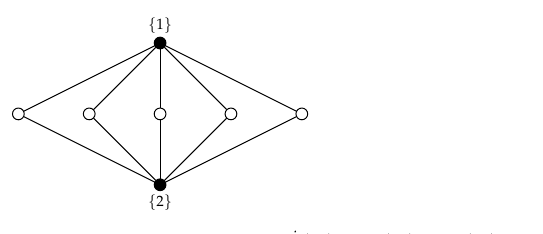
Figure 1. A graph G with γ oi